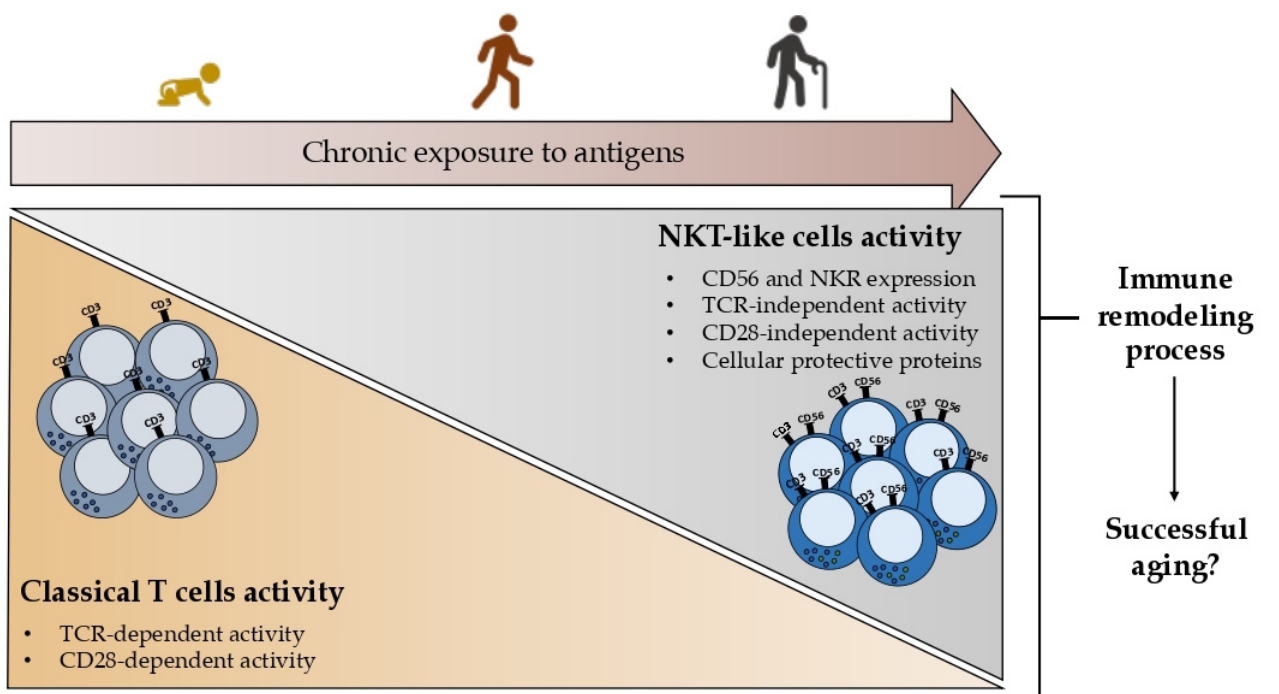
Figure 2. Illustration of the hypothesis that the age-related increase in NKT-like cells may result from long-term antigen exposure. In general, the TCR and CD28-dependent activity of classical T cells declines with age; conversely, NKT-like cells accumulate in the peripheral blood. Although the genesis of NKT-like cells is unknown, it has been hypothesized that the persistent antigen exposure of T cells may result in the acquisition of innate-like receptors, such as CD56. It is speculated that this mechanism, which is intimately tied to aging, occurs as an immunological remodeling process, and may assist or at the very least be associated with successful aging. Blue and green circles represent granules and cytokines, respectively.